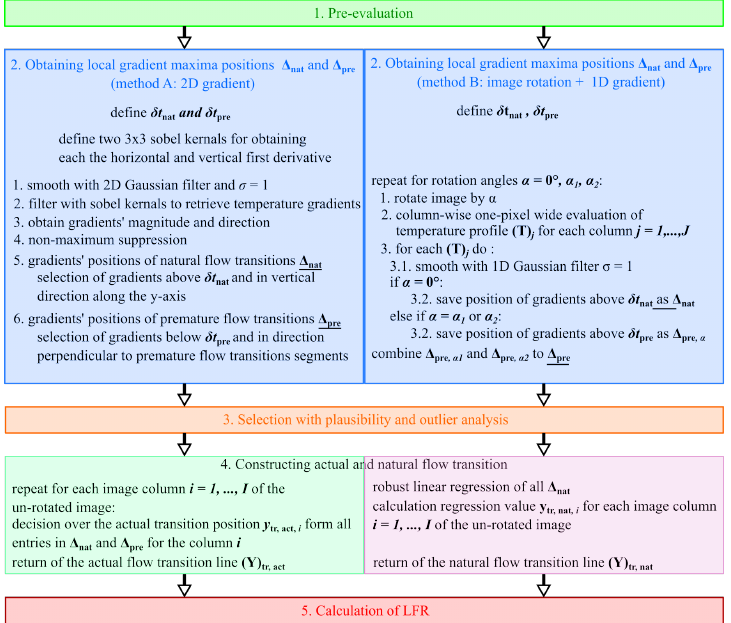
Figure 6. Flow chart of the image processing method, divided in five main parts: (1) A pre-evaluation of the thermographic image. (2) The localization of local gradient maxima. (3) Selection of gradients representing the flow transition. (4) Construction of the actual and natural flow transition line. (5) Calculation of the laminar flow